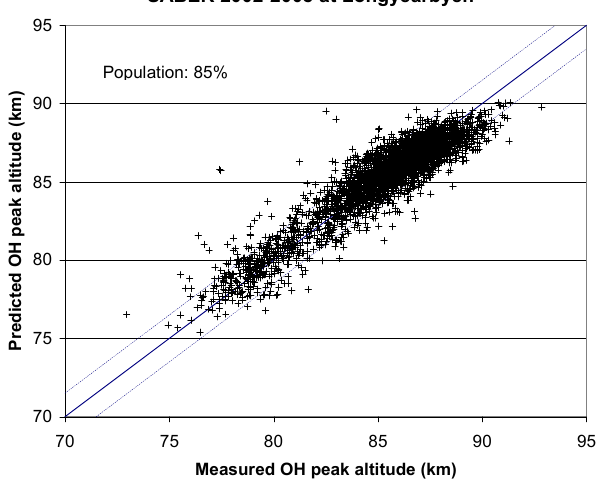
Fig. 3. Altitude of OH layer peak predicted by empirical formula versus altitude measured by SABER at Longyearbyen (78 ± 5 ◦ N, 16 ± 10 ◦ E) during